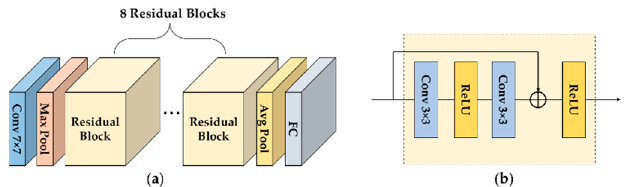
Figure 6. ( a ) Architecture of ResNet18 [35]/SimCLR [34] used for cell classification with ( b ) details of the residual block. the residual block.